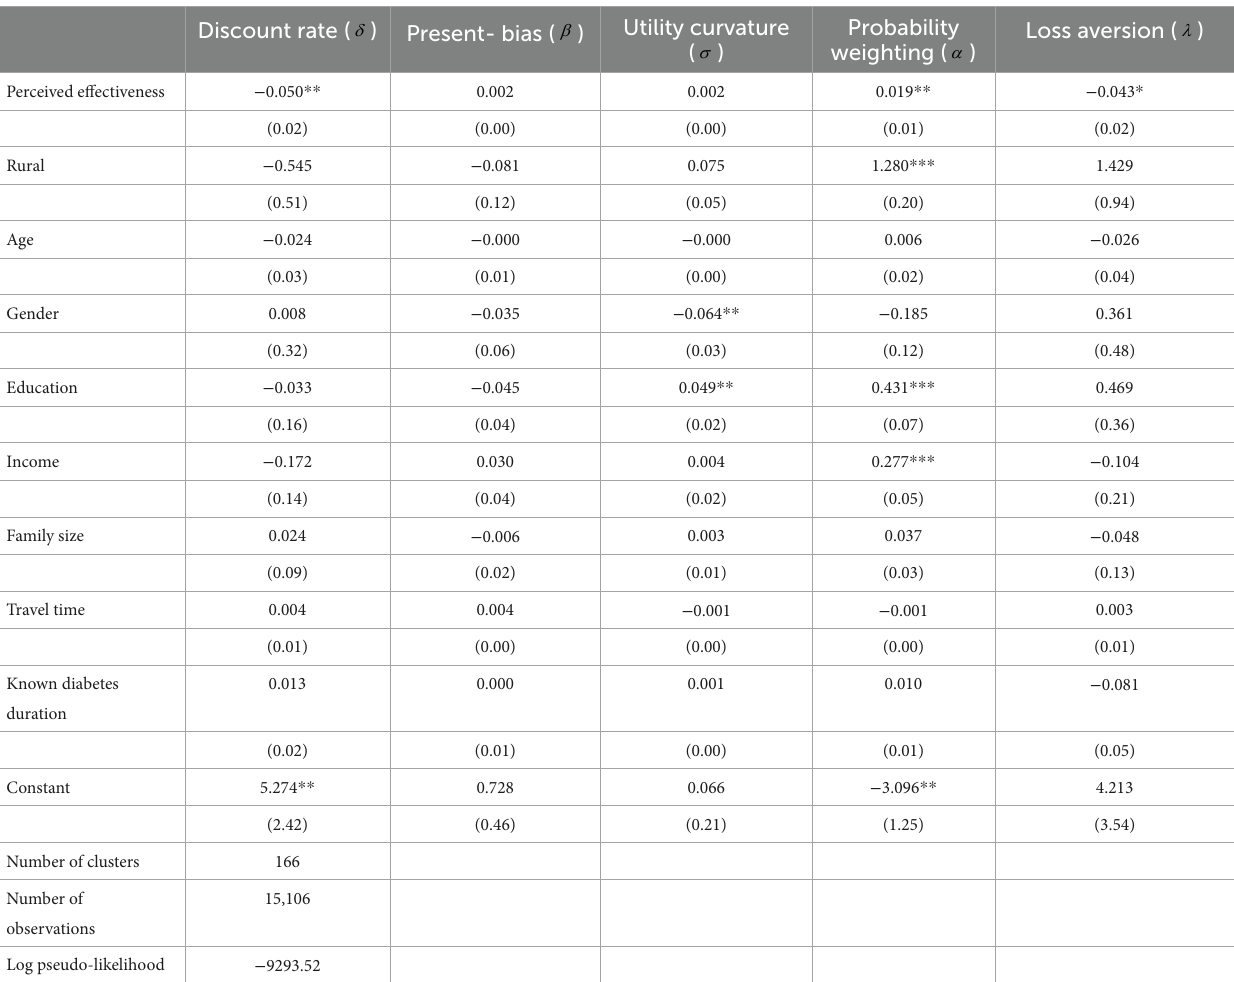
TABLE 4 Association between risk and time preferences and perceived effectiveness of intervention